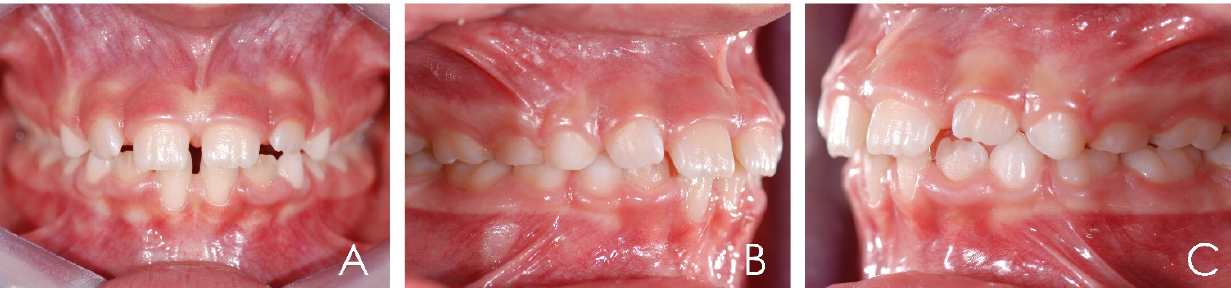
Figure 3. Initial intraoral photographs of the subject (10-year-old) showed canine class I, deep bite, vestibular inclination of the frontal teeth and atypical swallowing. ( A ) Frontal view; ( B , C ) lateral view.